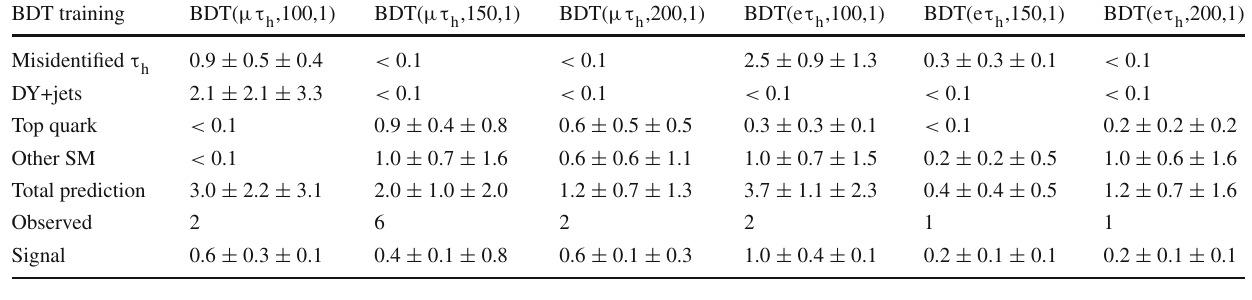
Table 6 Predicted background yields and observed event counts in the for left-handed (cid:2) τ pair production that is used to train the BDT. In the most sensitive last bins of the BDT distributions in the e τ and μτ bottom row, we list the corresponding predicted signal yields in the last h h final states, in data collected in 2017. The numbers in parentheses in bin of the BDT distribution. The first and second uncertainties given the first row are the (cid:2) τ and (cid:2) χ 0 masses corresponding to the signal model are statistical and systematic, respectively 1